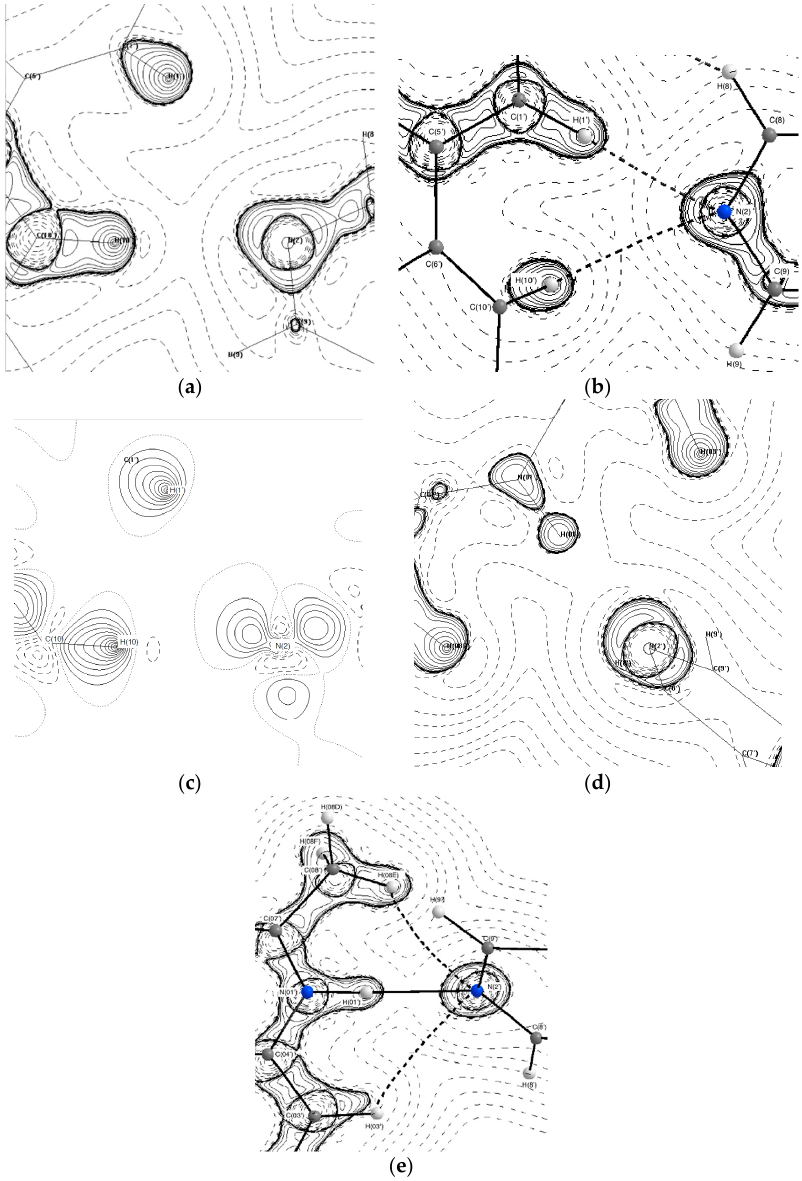
Figure 8 . Topological maps pf hydrogen bonding involving analogous nitrogen atoms in ( 2 ) ( a – c ) and ( 3 ) ( d , e ). ( a ) N(2) in EXP ( b ) N(2) single point (SP), ( c ) deformation density map of N(2), ( d ) N(2 ′ ) in EXP and ( e ) N(2 ′ ) in SP. Contour lines are plotted on a log scale. Solid lines indicate positive contours, and dashed lines indicate negative contours.